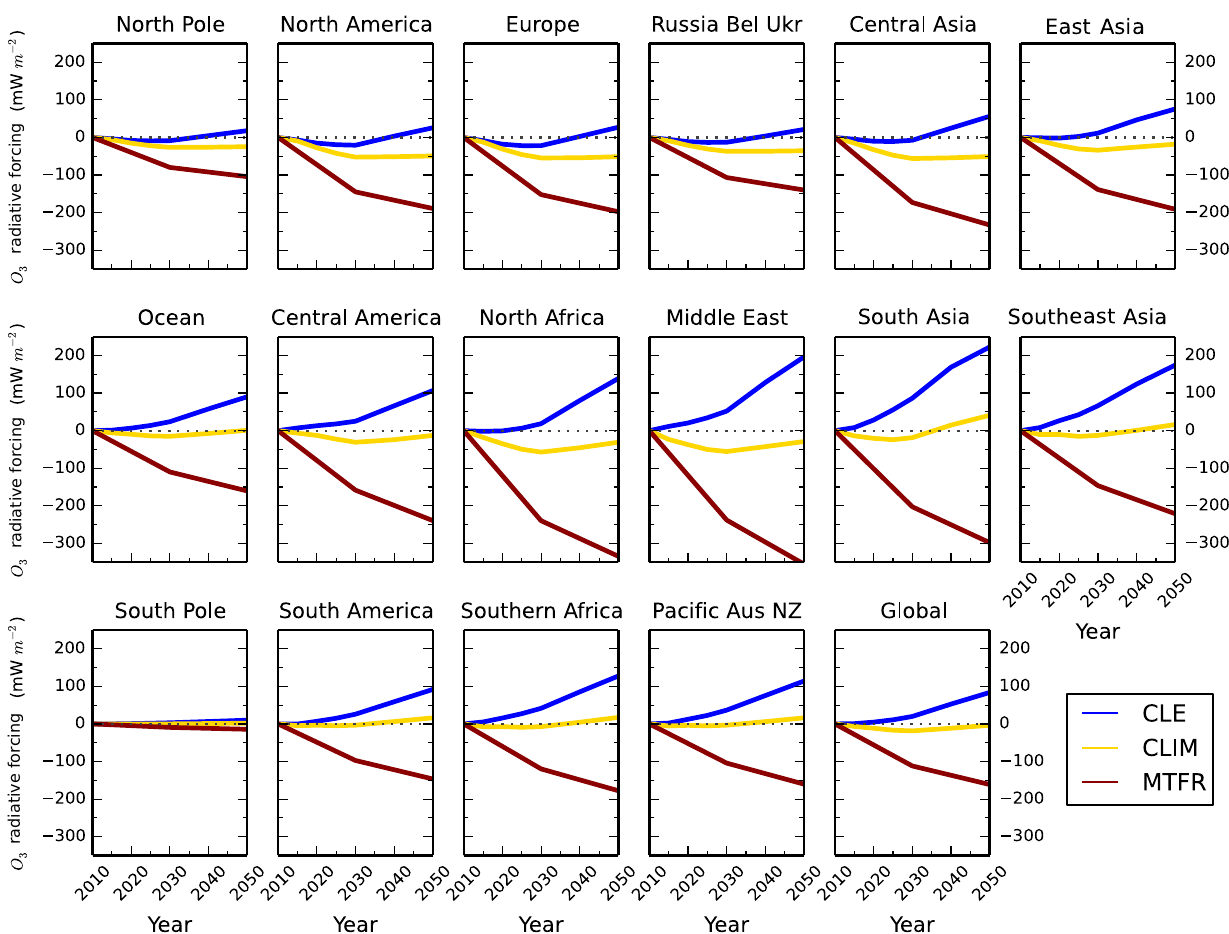
Figure 14. Annual mean regional O 3 radiative forcing relative to 2010 from the parameterisation for the ECLIPSE V5a emissions under the CLE (blue), CLIM (gold) and MTFR (red)